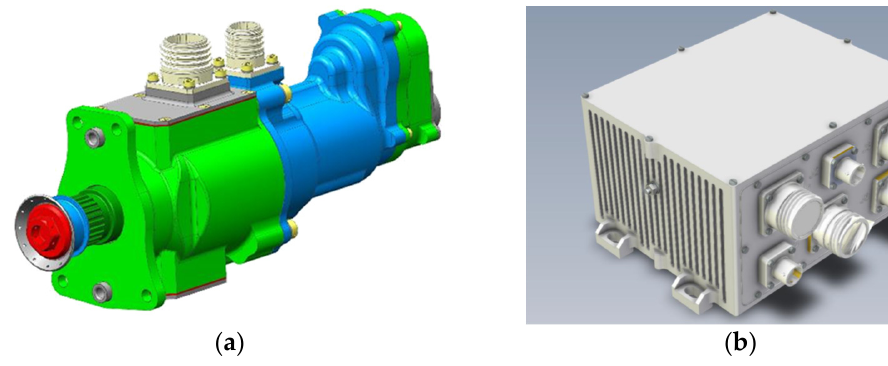
Figure 2. Flap EMA layout: ( a ) FLA; ( b ) ACE.